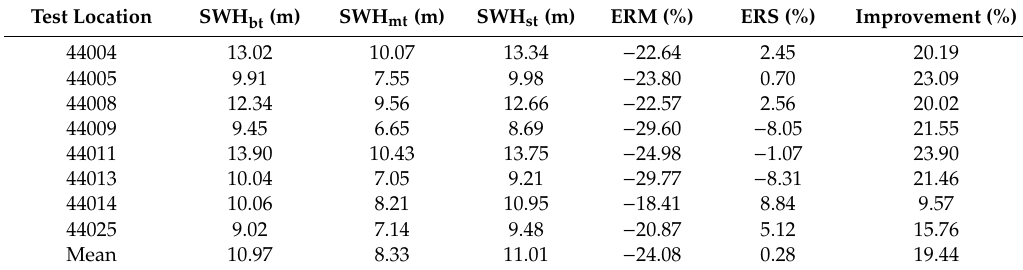
Table 3. Atlantic Coast: results for T R = 50 years.